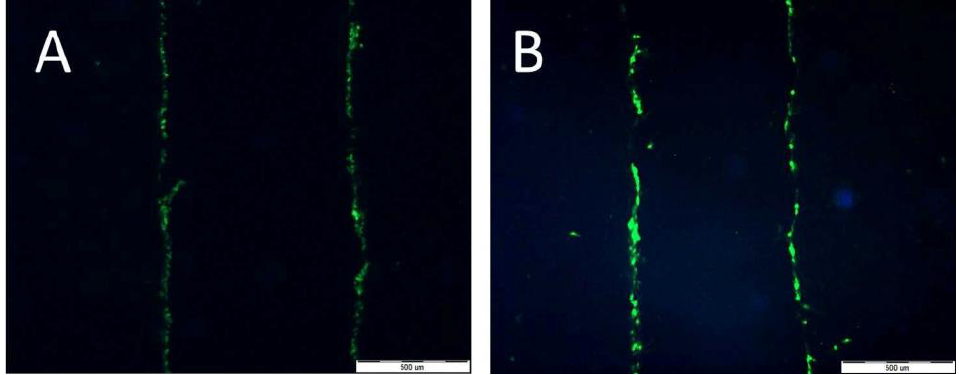
Molecules 2023 , 28 , x FOR PEER REVIEW Figure 10. Signal transmission between HT29 cells ( A ) and CCD 841 CoTr cells ( B ). Bar 500 µm.